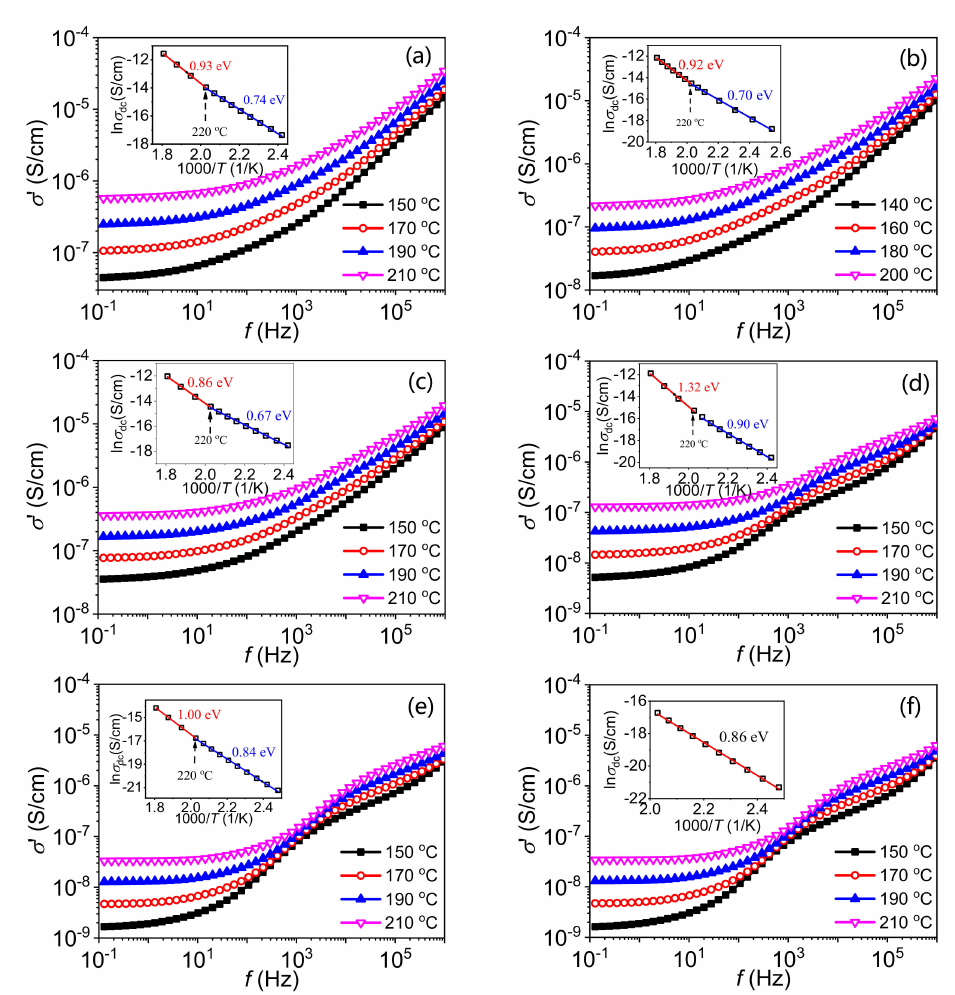
Figure 7. Admittance spectra of the Q-1200-2h ( a ), Q-1000 ( b ), Q-800 ( c ), Q-600 ( d ), Q-400 ( e ) and as-prepared samples ( f ). Insets are activation energies calculated by the Arrhenius relation between DC conductivities and the measuring